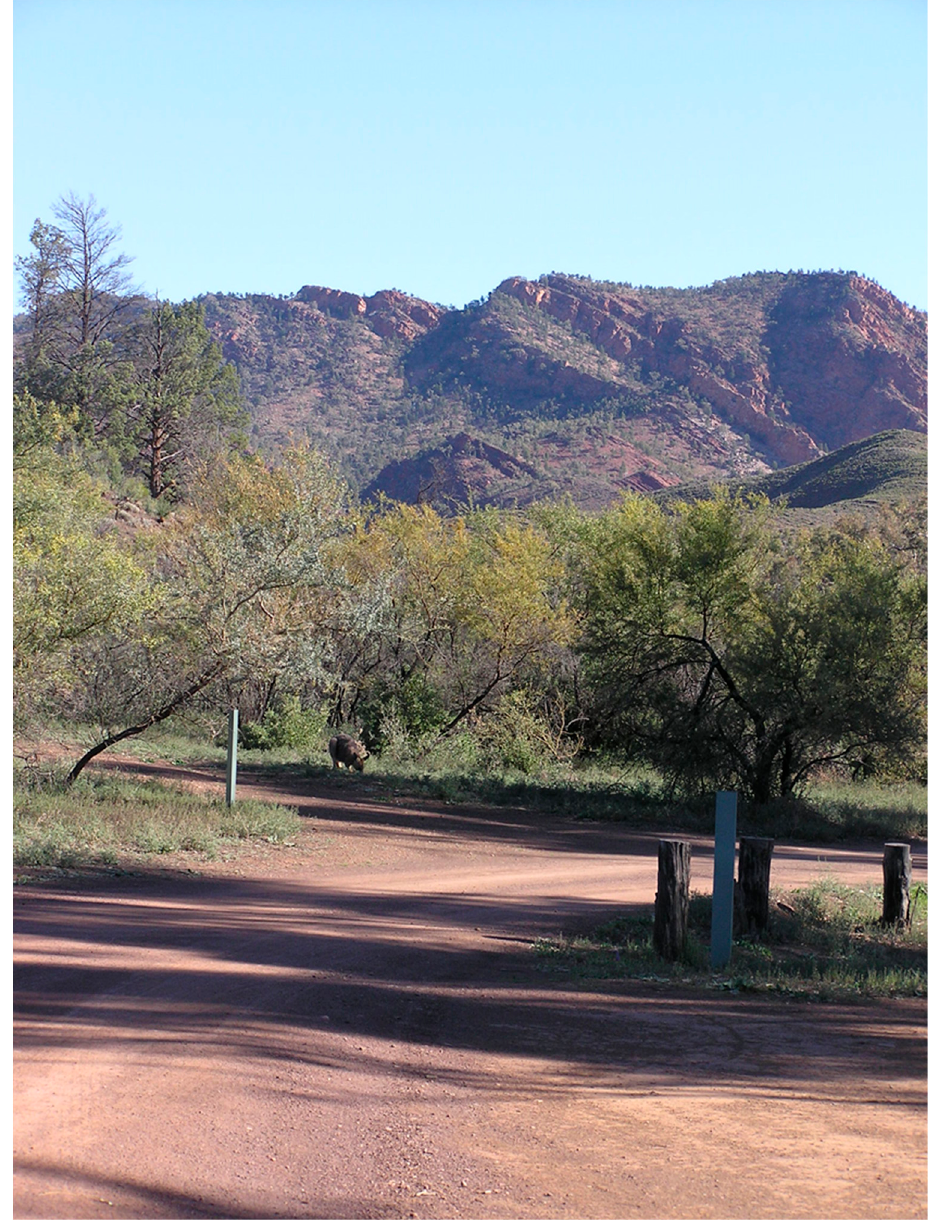
Figure 3. Entry to the camping ground in Flinders Ranges National Park, South Australia (Image: D.B. Croft).